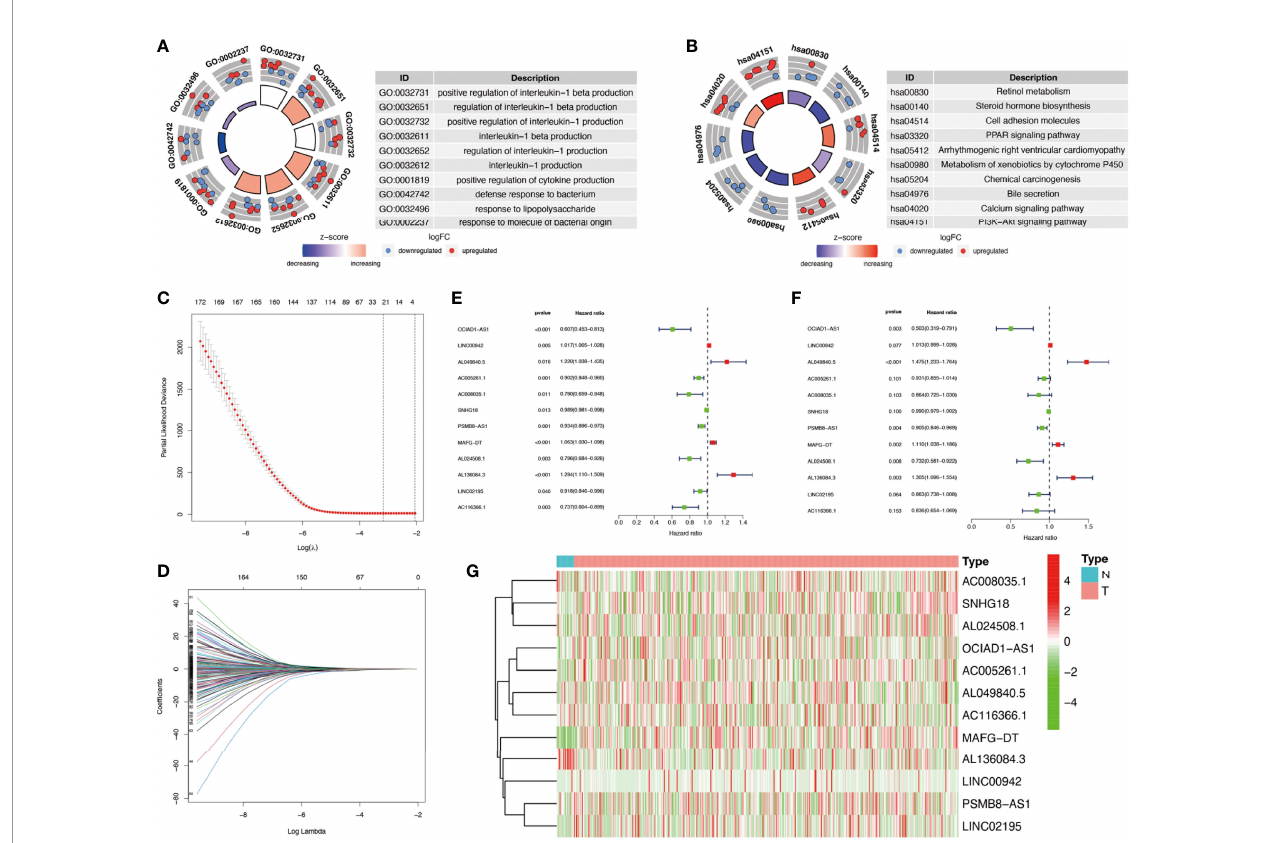
FIGURE 1 | Identi fi cation of co-expressed pyroptosis-related lncRNAs. (A, B) Circle plots of Gene Ontology (GO) terms and Kyoto Encyclopedia of Genes and Genomes (KEGG) pathway analysis for pyroptosis-related genes. The outer circle of circle plots showed a scatter plot for each term of the logFC of the assigned genes. Red circles represented upregulation, and blue ones represented downregulation. (C, D) Identi fi cation of overall survival (OS)-related pyroptosis lncRNAs using the least absolute shrinkage and selection operator (LASSO) regression algorithm. (E, F) A forest map showed 12 pyroptosis-related lncRNAs identi fi ed by Cox proportional hazards regression in the meta-data cohort and validation cohort. (G) The heatmap of pyroptosis-related lncRNAs based on their expression levels.